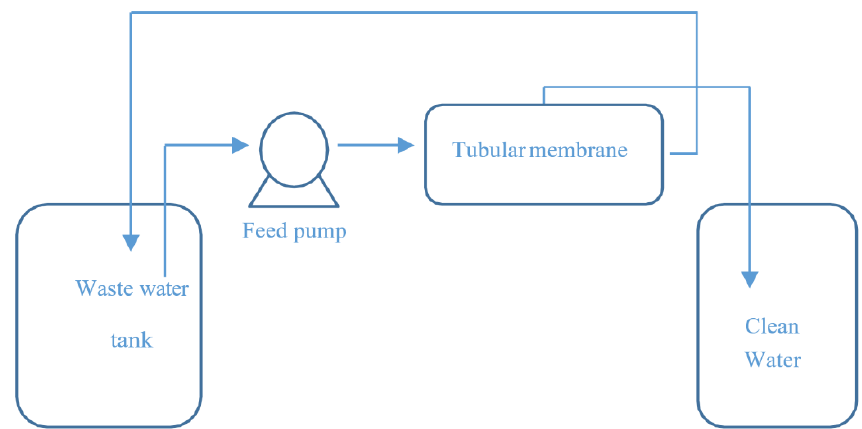
Figure 2. Sketch the experimental filtration process.